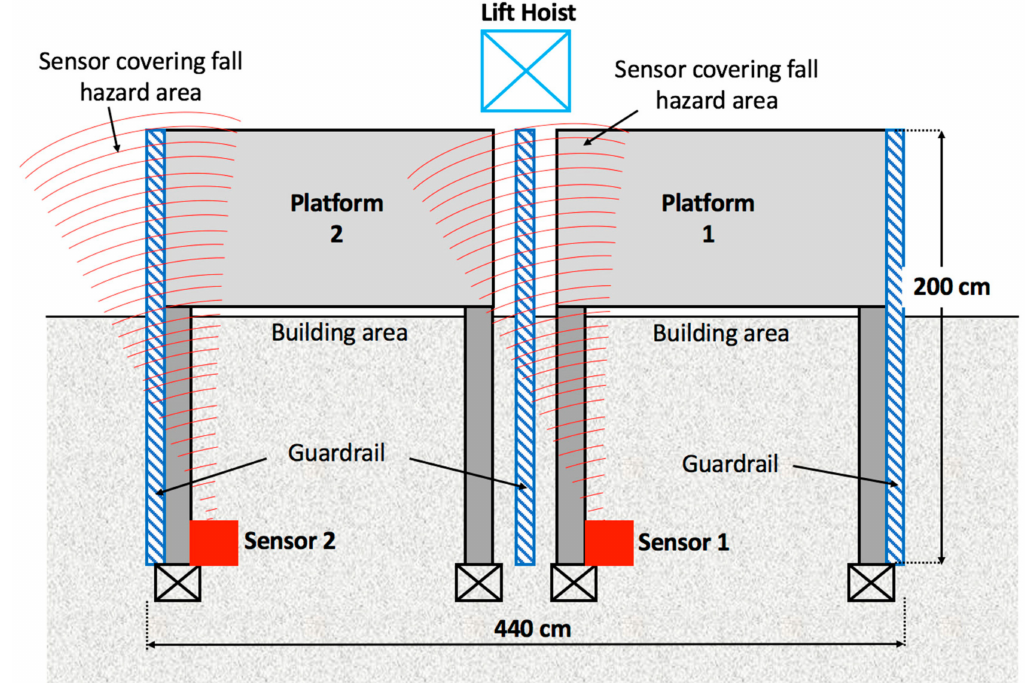
Figure 6. Sensor detection areas (top